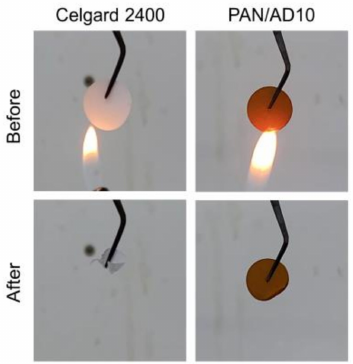
Figure 4. Digital photographs of the burning test for Celgard 2400 and PAN/AD10. The membranes were completely wet with LE (1 M LiPF 6 in EC/DMC (1/1 v/v